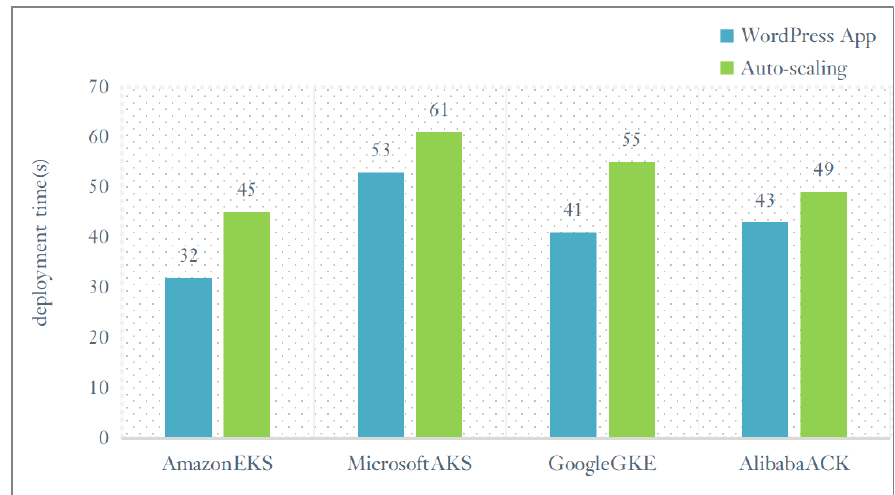
Figure 11. Deployment times on managed Kubernetes service.